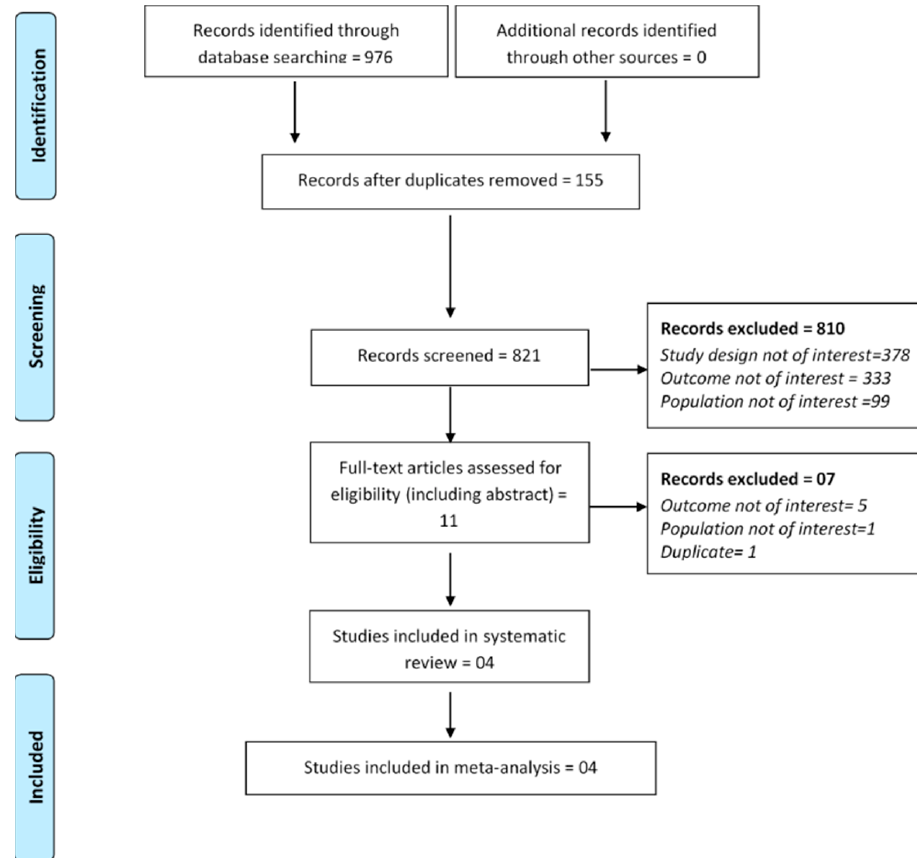
Figure 1. PRISMA flowchart showing study inclusion process .